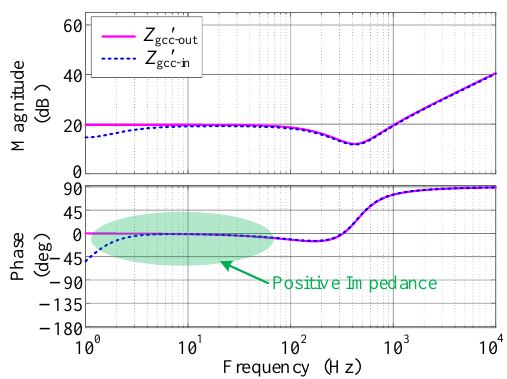
reshaped from negative resistance ( − R) to positive resistance (+R) at low frequency under IRSE control, which means the proposed control is quite effective.